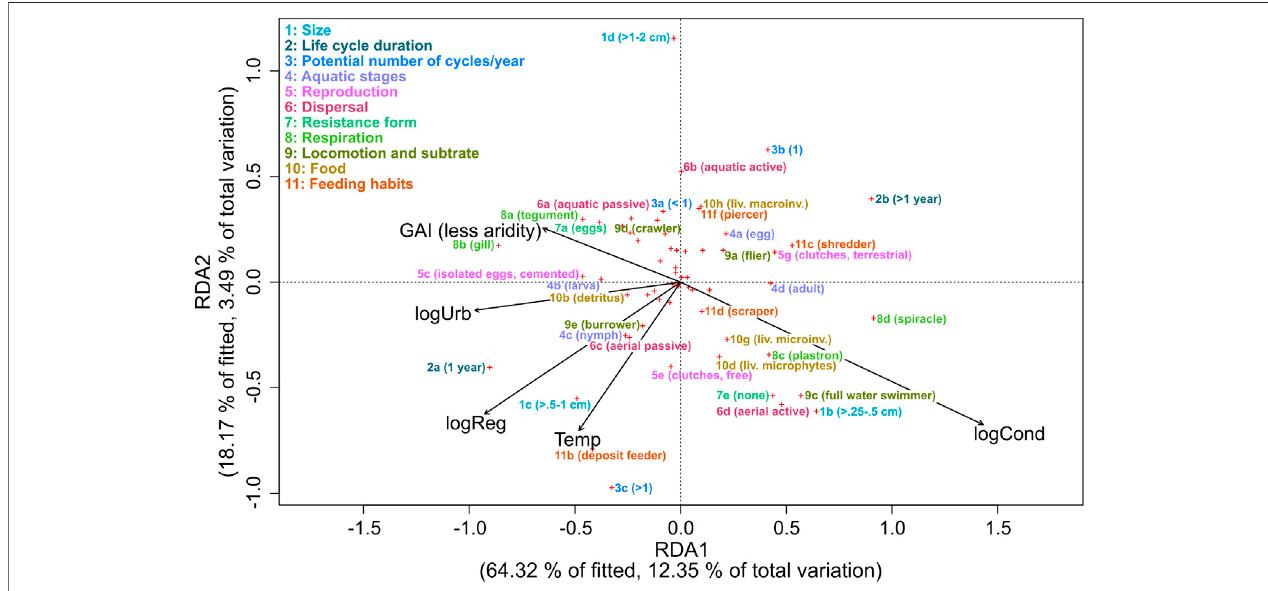
FIGURE 4 | RDA ordination distance triplot (Scaling 1) with the relationship of environmental variables (conductivity (log-transformed; logCond), degree of regulation (log-transformed; logReg), water temperature (Temp) urban extent (log-transformed; logUrb), and Global Aridity Index (GAI)), and traits in Northwest Africa. Only traits that correlate strongly with the environmental variables are displayed with